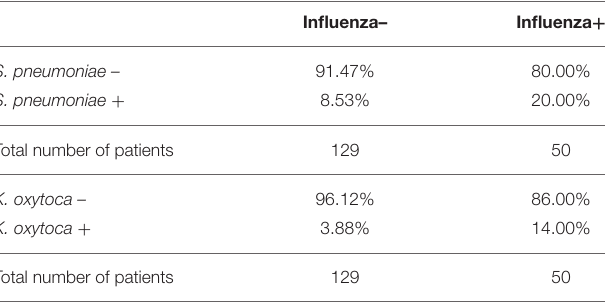
TABLE 1 | Influenza patients are more susceptible to bacterial colonization by Streptococcus pneumoniae and Klebsiella oxytoca